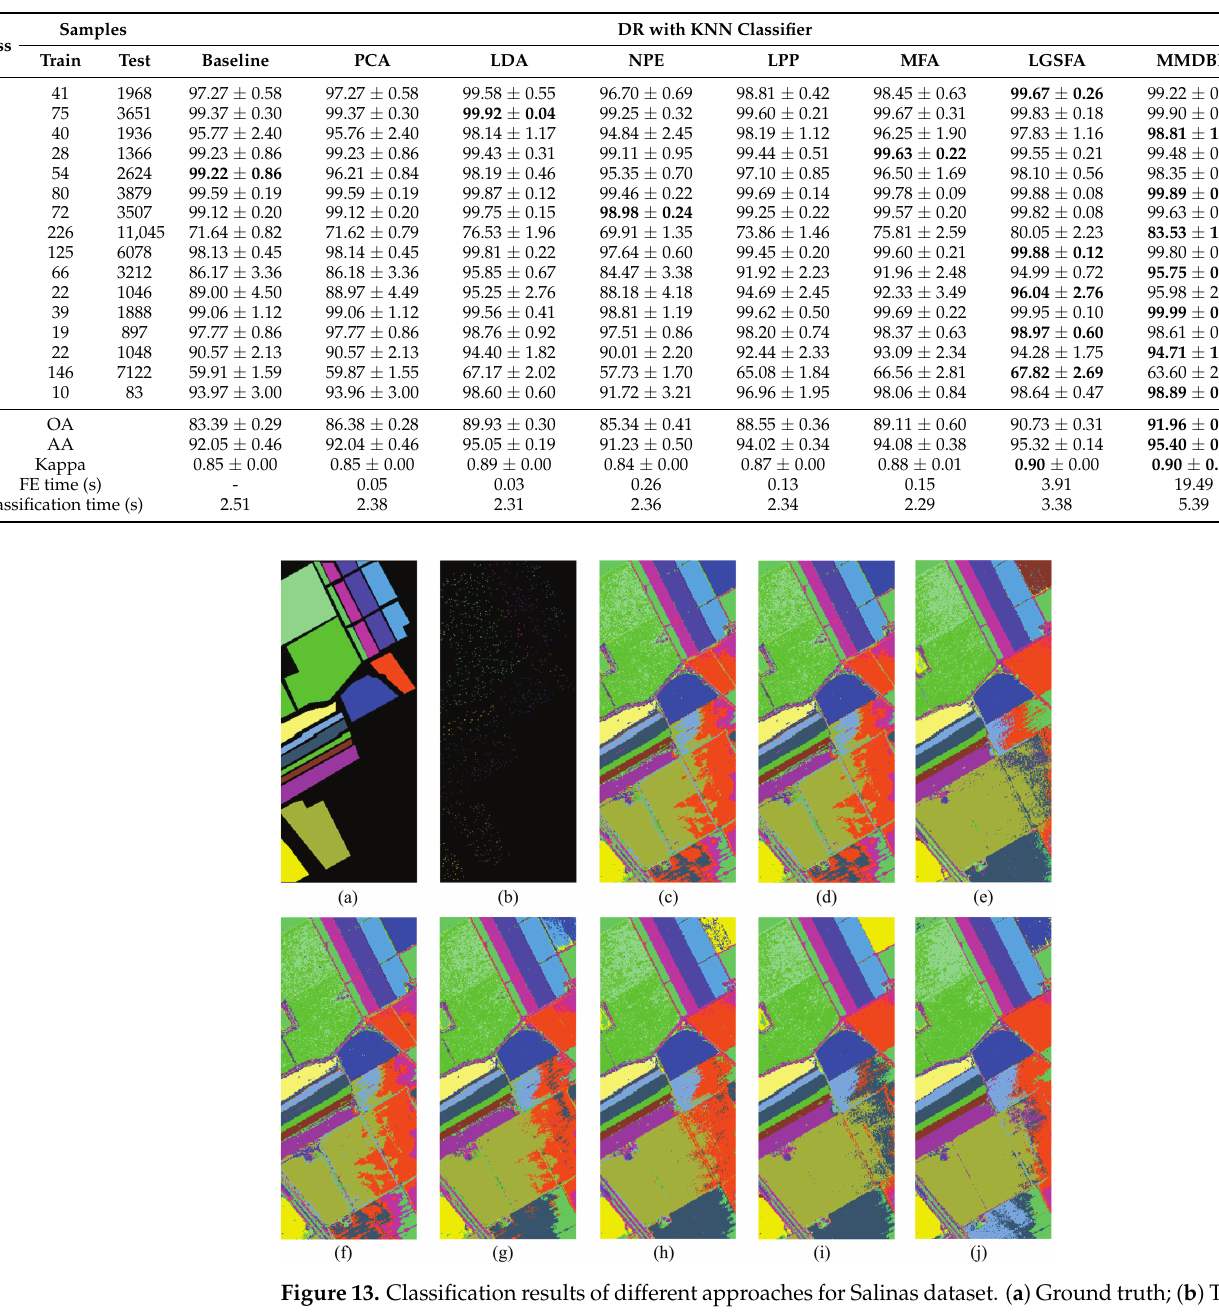
Table 5. Classification results of each class samples via different DR methods for Salinas dataset (%).